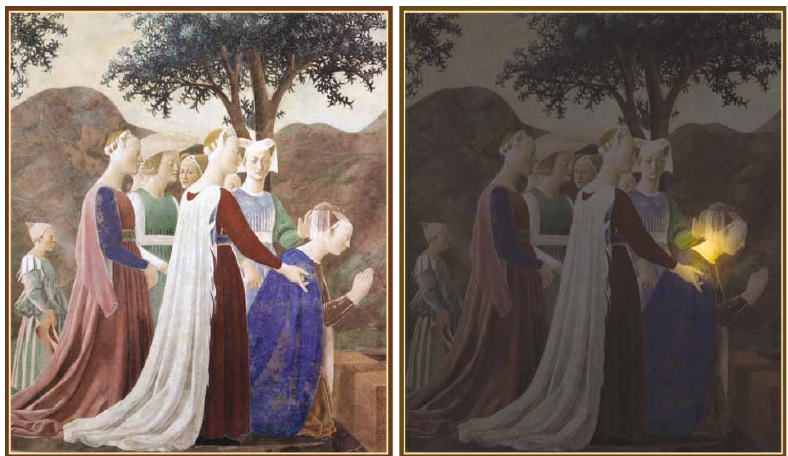
Figs. 5–6. Piero della Francesca. The Legend of the True Cross